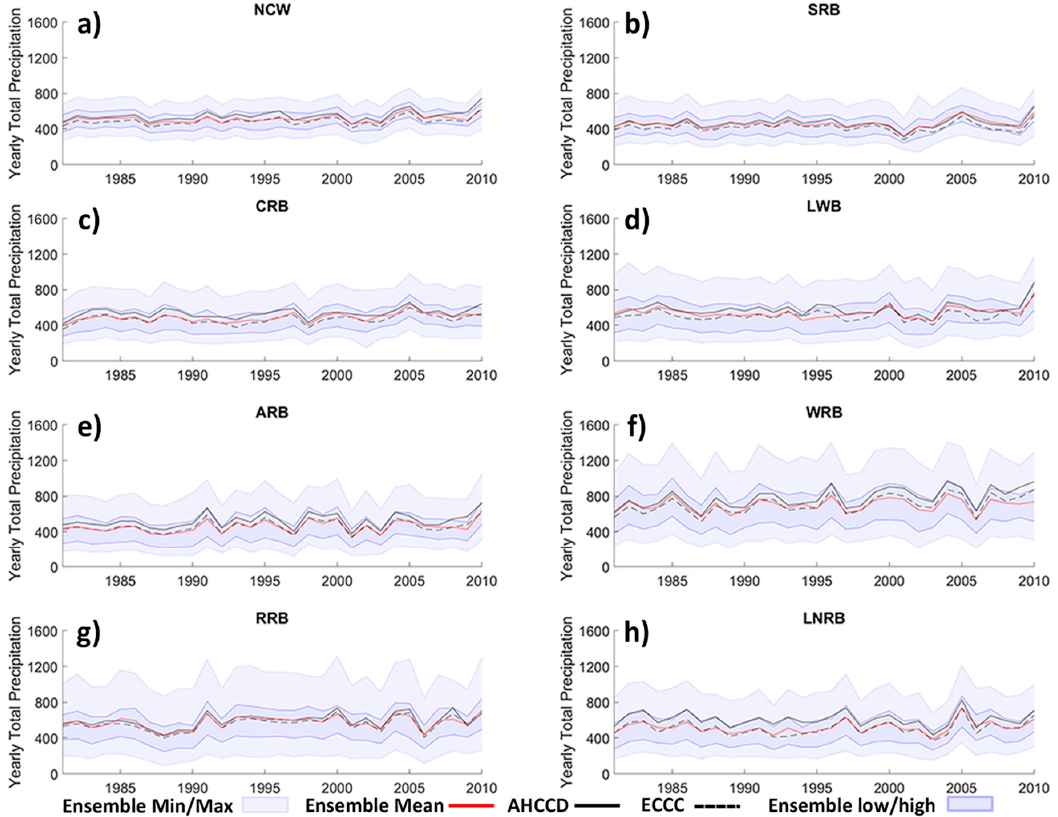
Figure 5. Basin-averaged annual total precipitation timeseries showing the ensemble minimum, mean, and maximum; the high and low ensemble realizations generated from taking the second wettest and second driest value for each timestep and grid; as well as ECCC and AHCCD for each sub-basin in the NCW (1981–2010): ( a ) NCW, ( b ) SRB, ( c ) CRB, ( d ) LWB, ( e ) ARB, ( f ) WRB, ( g ) RRB, ( h ) LNRB.